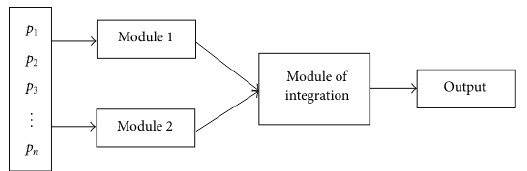
Figure 5. The MNN structure with 2